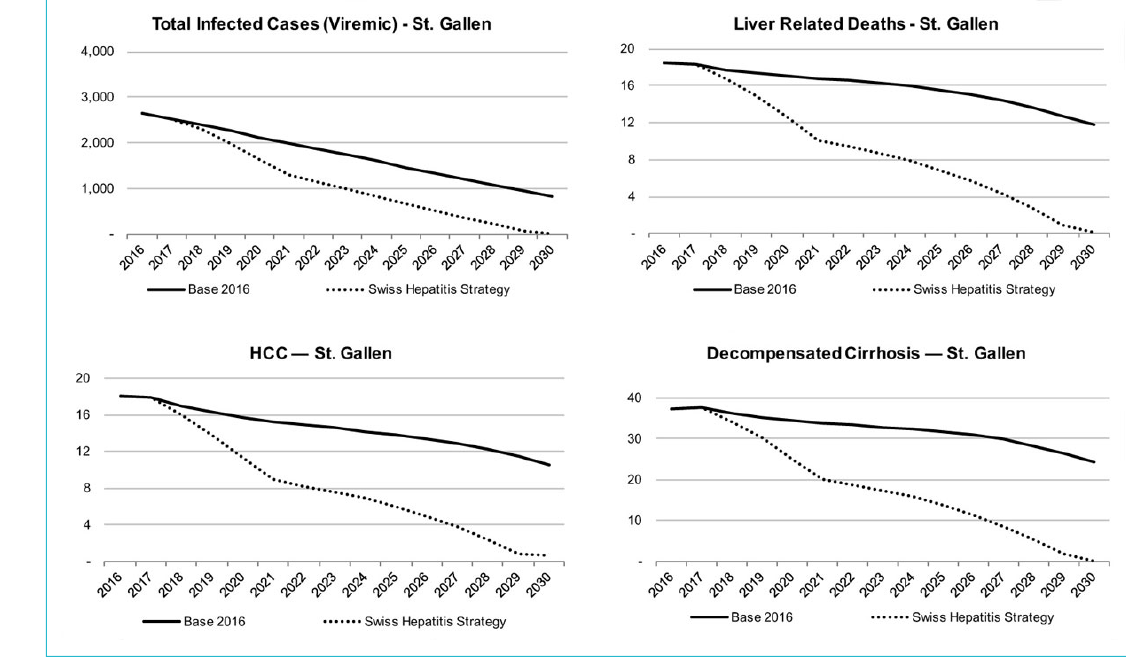
Figure 13: Total viraemic infections, liver related morbidity and mortality by scenario for the canton of St